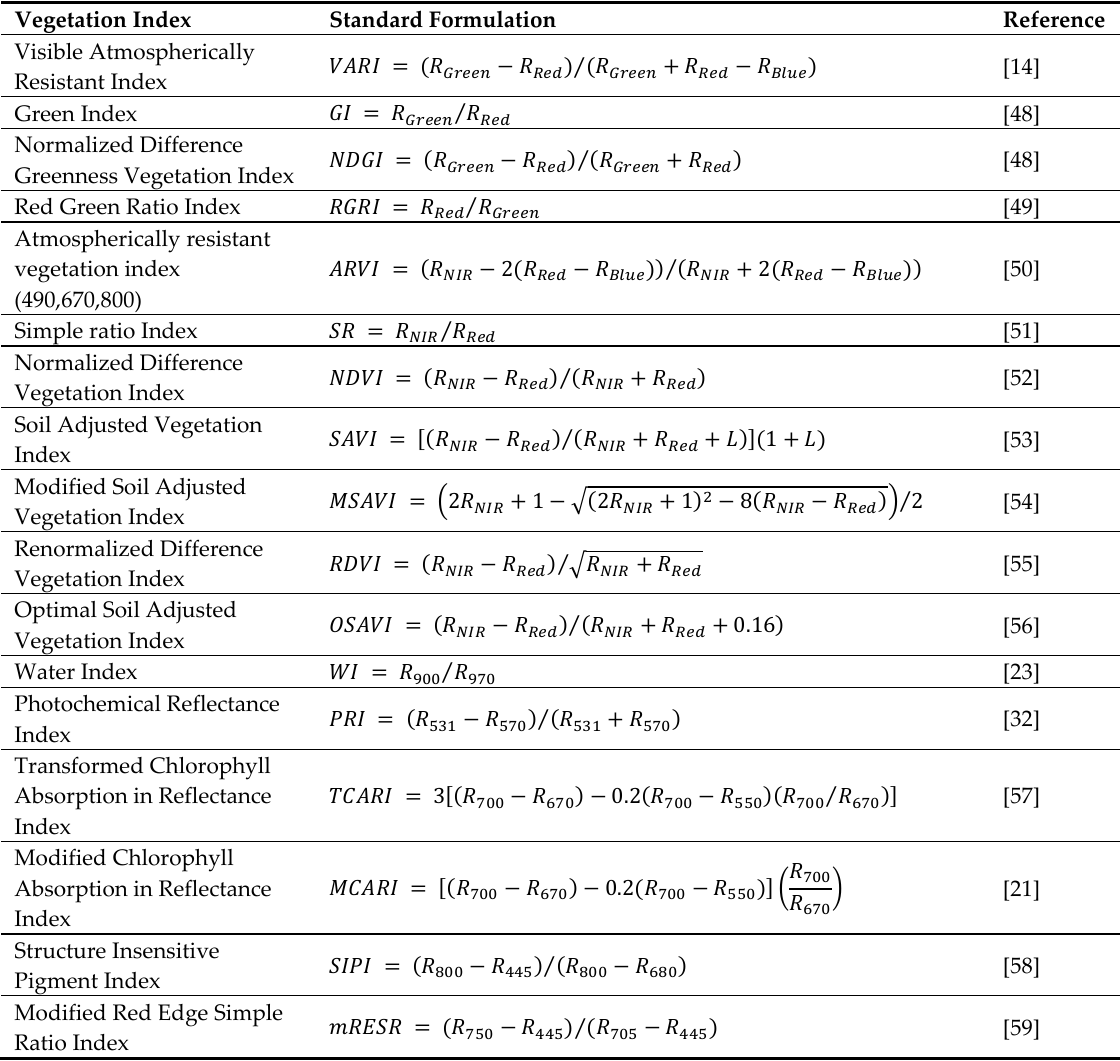
Table 1. Vegetation indices (standard formulations) considered in the current